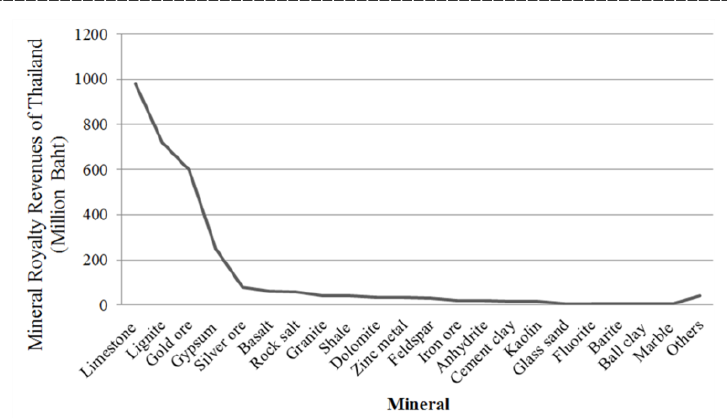
Fig. 2. Mineral royalty revenues of Thailand in 2013.